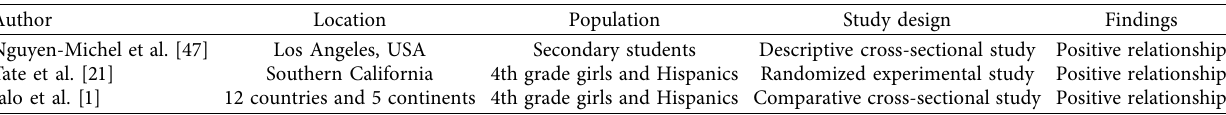
Table 3: Studies that report a relationship between negative emotions and hyperpalatable energy-dense food intake in children and adolescents.